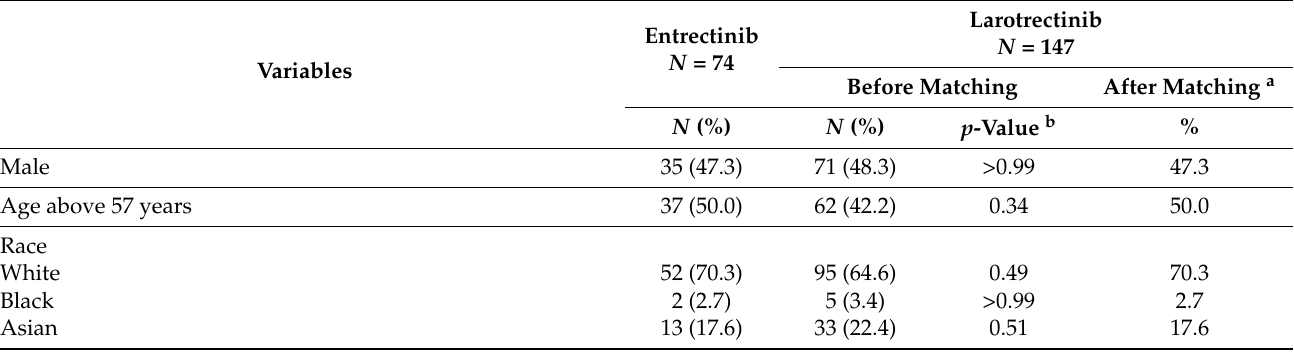
Table 2. Baseline characteristics before and after matching of larotrectinib safety population and